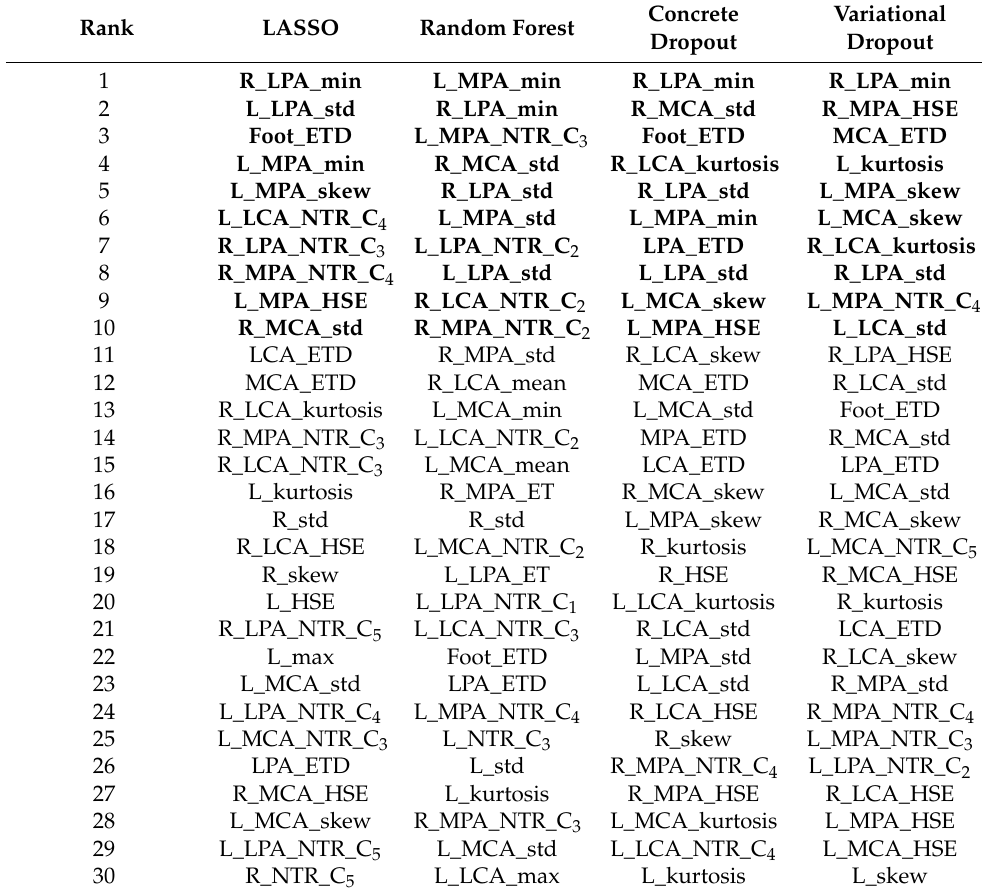
Figure 4. The sparse rate obtained in the variational feature selector using τ > 0.9 as threshold in the different cross-validation iterations. Table 3. The 30 most relevant features extracted, listed according to rank, for all the approaches considered: LASSO, random forest, and concrete and variational dropout. The 10 first features are highlighted in bold as the most relevant for each method. The nomenclature employed is defined in Section